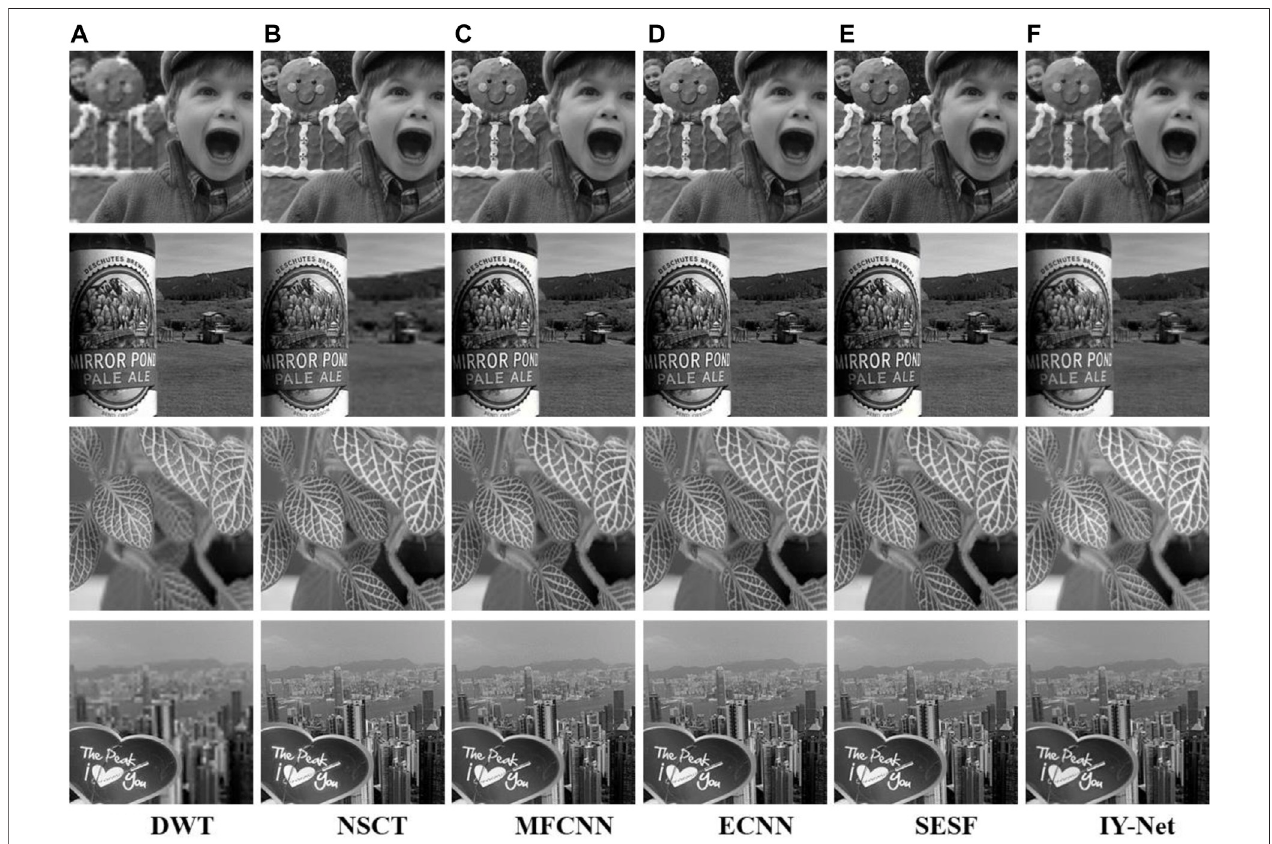
FIGURE 5 | Experiment on 4 pairs of multi-focus images. (A) DWT, (B) NSCT, (C) MFCNN, (D) ECNN, (E) SESF, (F) IY-Net.